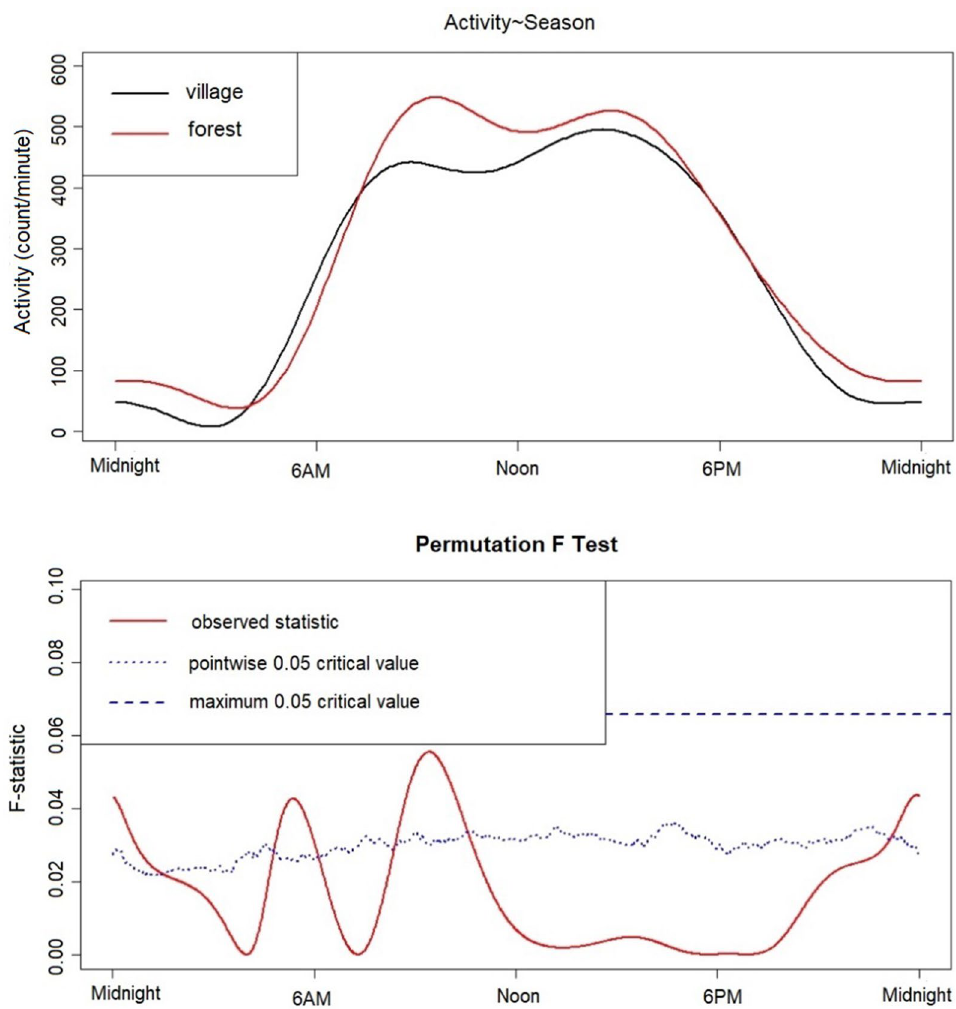
Figure 4. Functional linear modelling comparing 24-h sleep–wake patterns of BaYaka in the forest and village locations. The forest location is represented by a red line and the village represented by a black line. Bottom part of the illustration displays the permutation F test; significant values of the F-statistic cross the line of the critical value (dotted